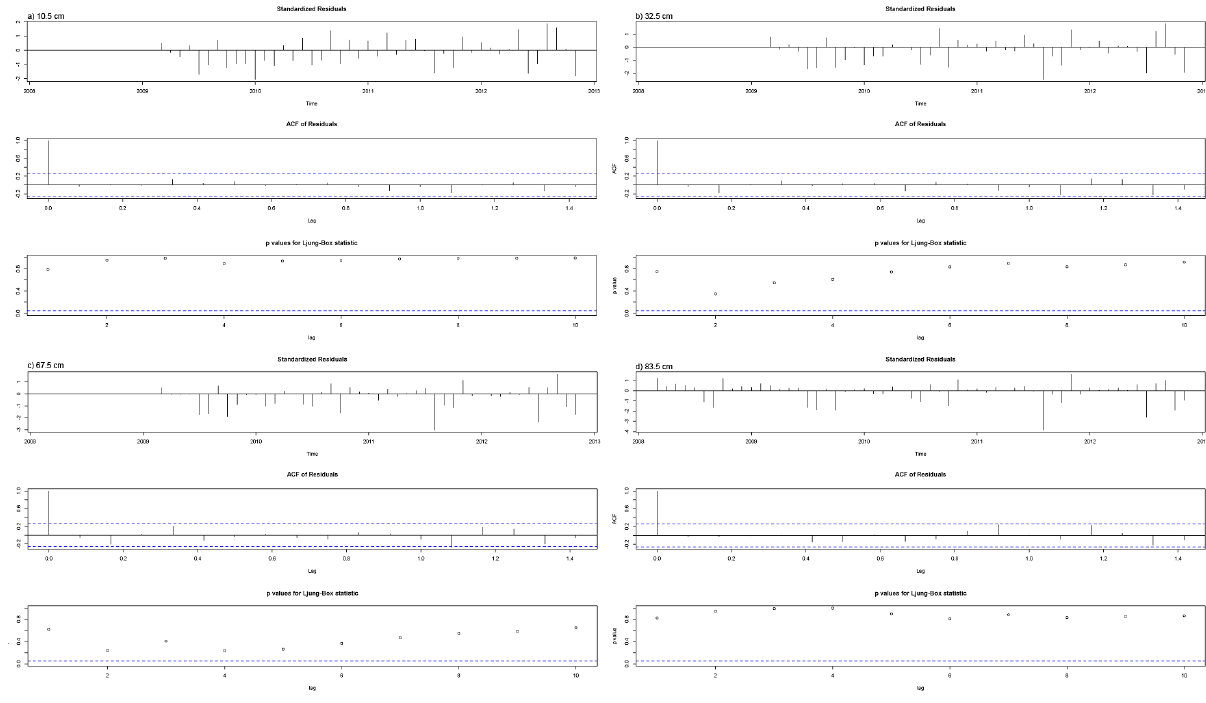
Figure 9. Standardized residuals, autocorrelation plot and Ljung–Box statistics for ARIMA models fitted to F1, F2, F3 and F4.